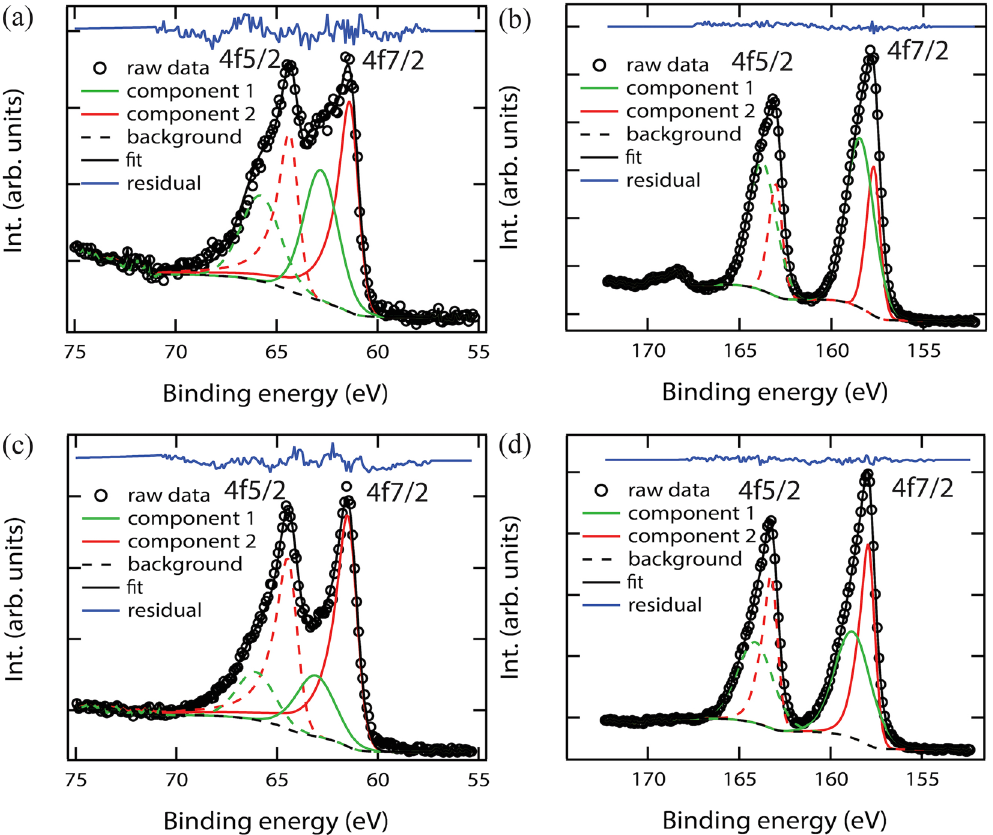
Figure 3. XPS ( a ) Ir 4f 5/2 and 4f 7/2 spectra and ( b ) Bi 4f 5/2 and 4f 7/2 spectra taken on film f1. ( c ) Ir 4f 5/2 and 4f 7/2 spectra and ( d ) Bi 4f 5/2 and 4f 7/2 spectra taken on film f3. The spectra were fitted using two components: a symmetric component (higher binding energy peak) described by the Gaussian-Lorentz profile GL(m), and an asymmetric component (lower binding energy peak) by the convolution of Gelius profile A(a,b,n) and Gaussian-Lorentz profile GL(m). The parameters a and b are optimized as described in the supplementary information.